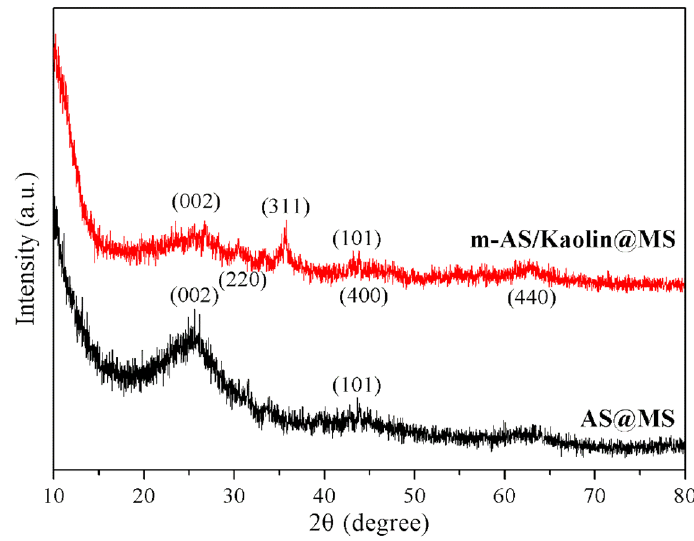
Figure 4. XRD diffractograms of the AS@MS and m-AS/Kaolin@MS.